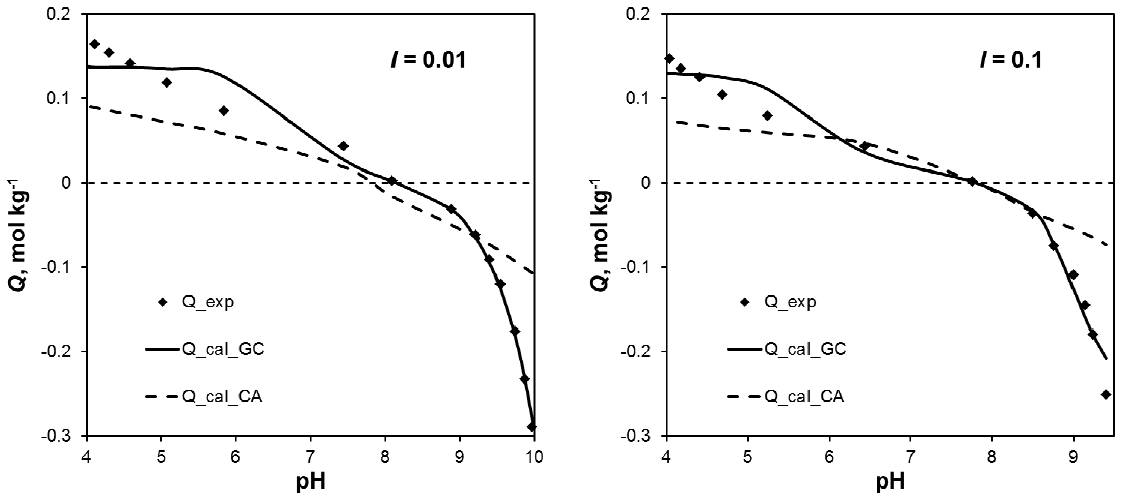
Figure 3: MA - Bentonite/magnetite (B:M = 2:1) sample – titration curves evaluated using GC- and CA-approach